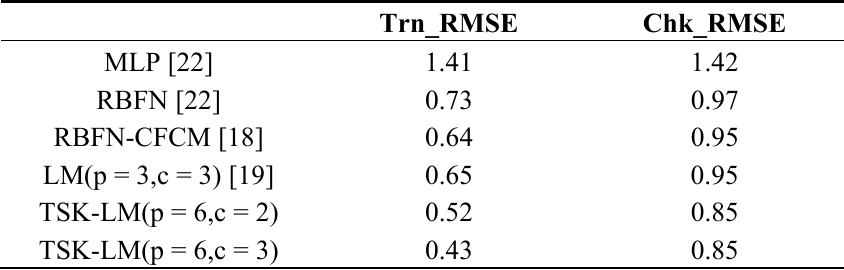
Table 2. Performance comparison of RMSE (indoor).